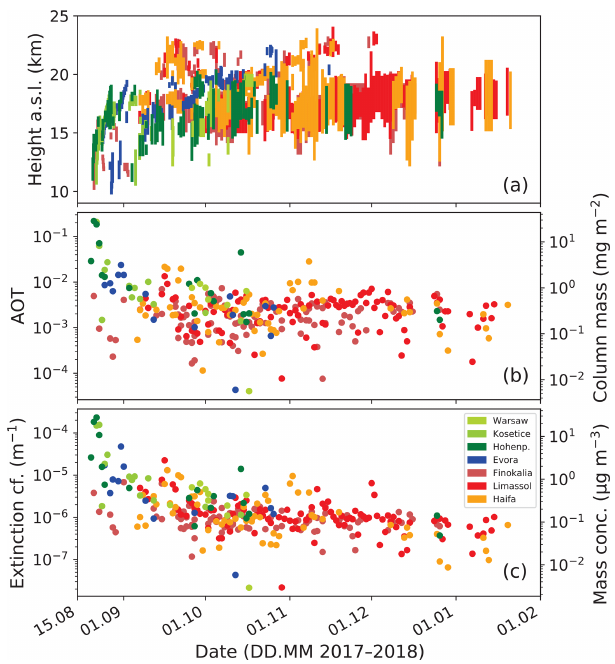
Figure 4. (a) Overview of all Polly observations of the stratospheric smoke layer (from base to top as colored vertical lines). For each station, one nighttime observation per day is considered. (b) Cor- responding smoke layer AOT at 532nm and estimated column- integrated smoke particle mass concentration and (c) vertically aver- aged smoke particle extinction coefficient and corresponding mean particle mass